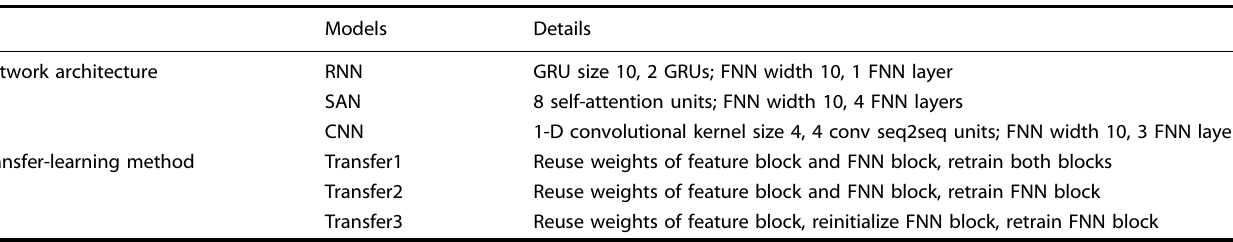
Table 3. Details of the neural network architectures and transfer-learning models.